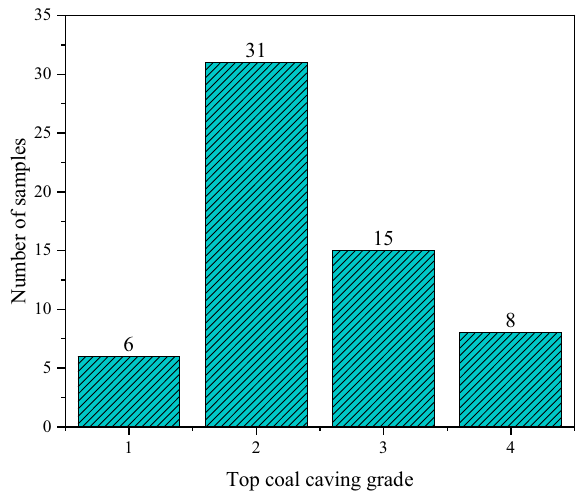
Figure 3. Top coal cavability grade distribution.